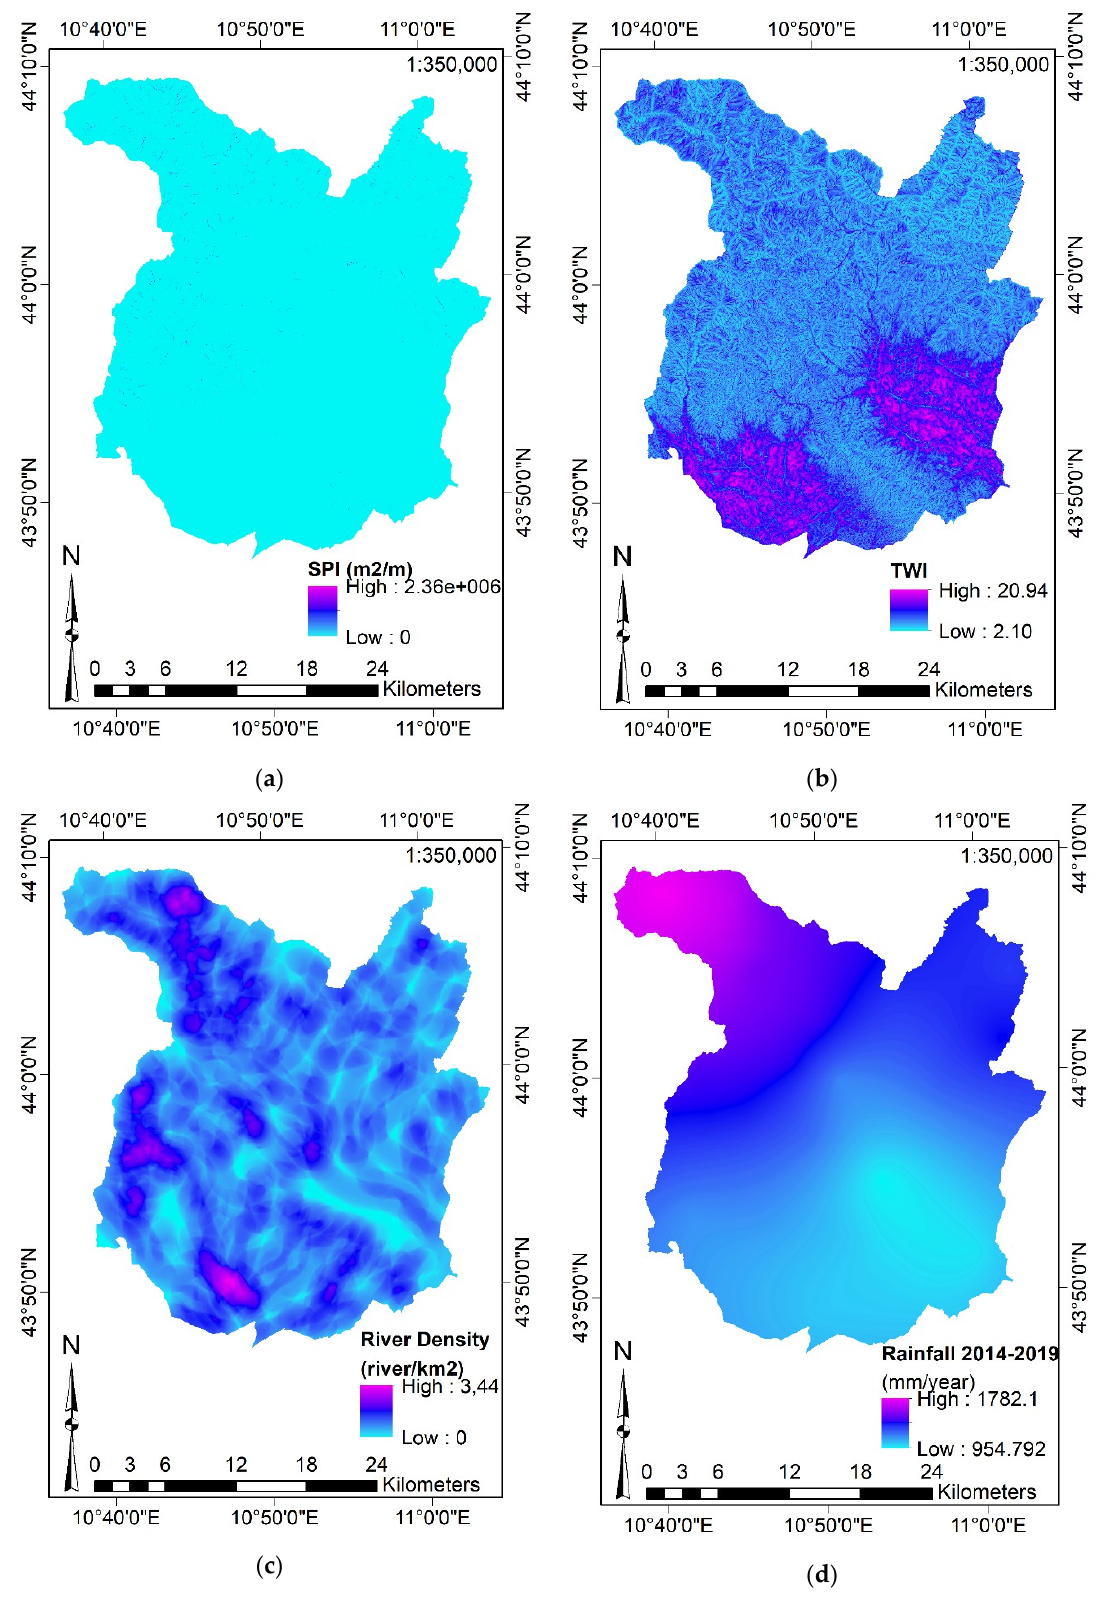
Figure A6. Input features—hydrological-based computed factors: ( a ) SPI; ( b ) TWI; ( c ) River density; ( d ) Rainfall.